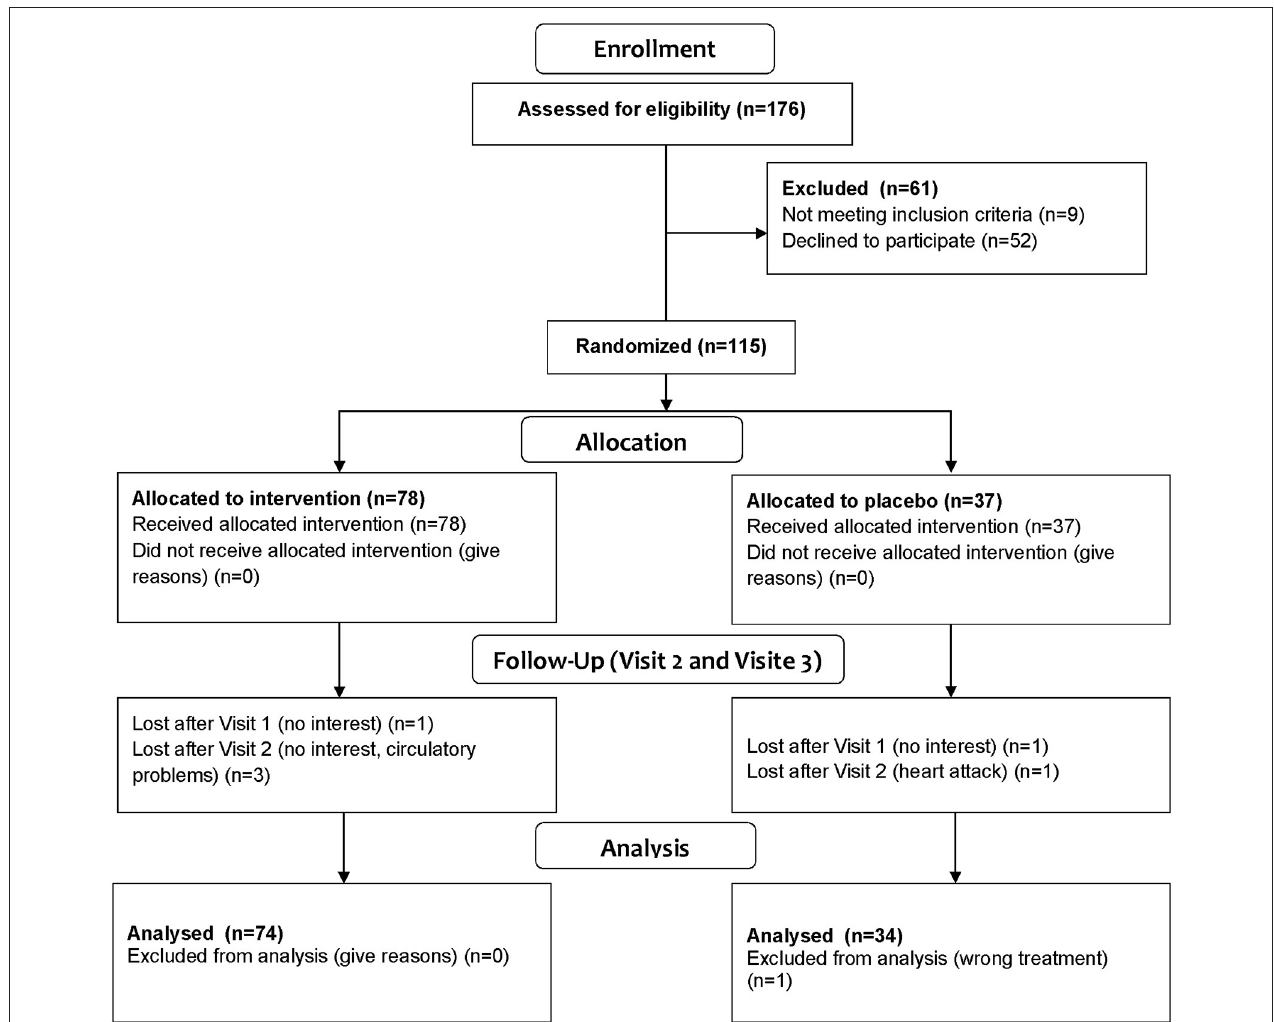
FIGURE 1 | CONSORT flow chart of study participants and